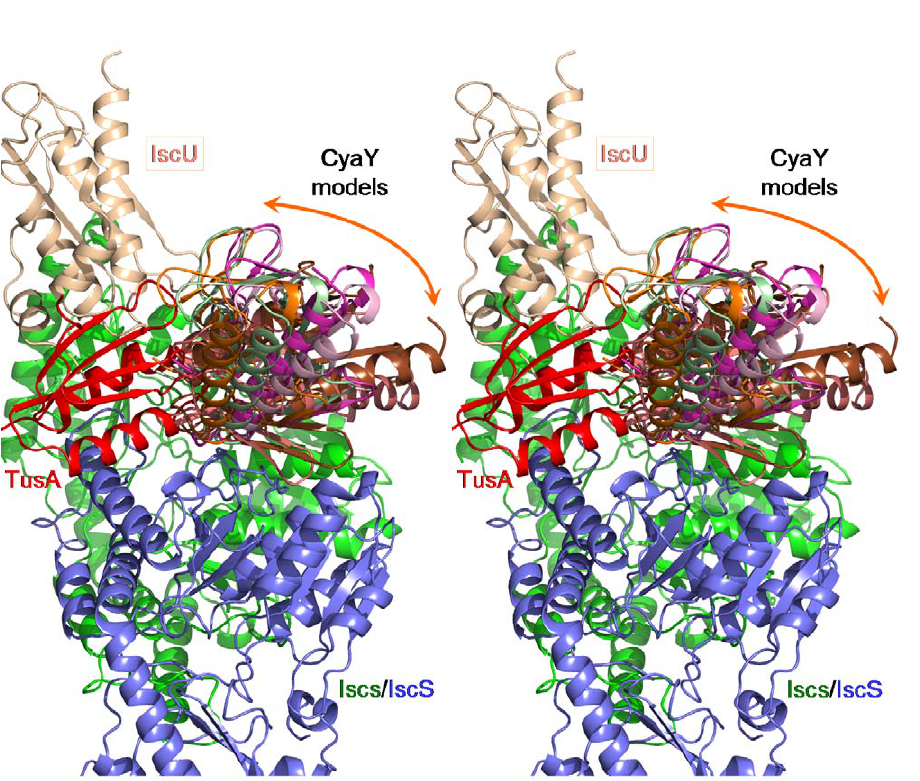
Figure 9. Modeling of the IscS-CyaY complex using the interface residues on CyaY identified by NMR [ 14 ] and residues of IscS important for binding to CyaY as identified here. The top 6 CyaY models are shown. The IscS subunits are painted green and slate. The overlapping CyaY models are shown in different colors. The locations of IscU (wheat) and TusA (red) relative to IscS are also shown. There are no steric conflicts between IscU and any of the CyaY models. The TusA molecule, however, clashes with all of the top models of CyaY, as was expected from the competition experiments.